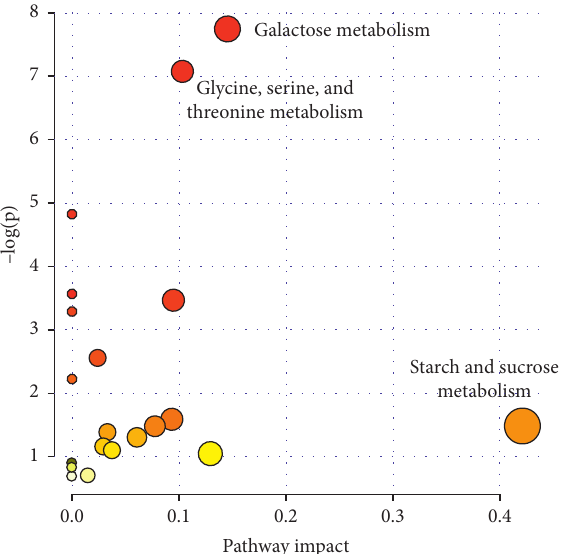
Figure 5: Pathway analysis based on significant